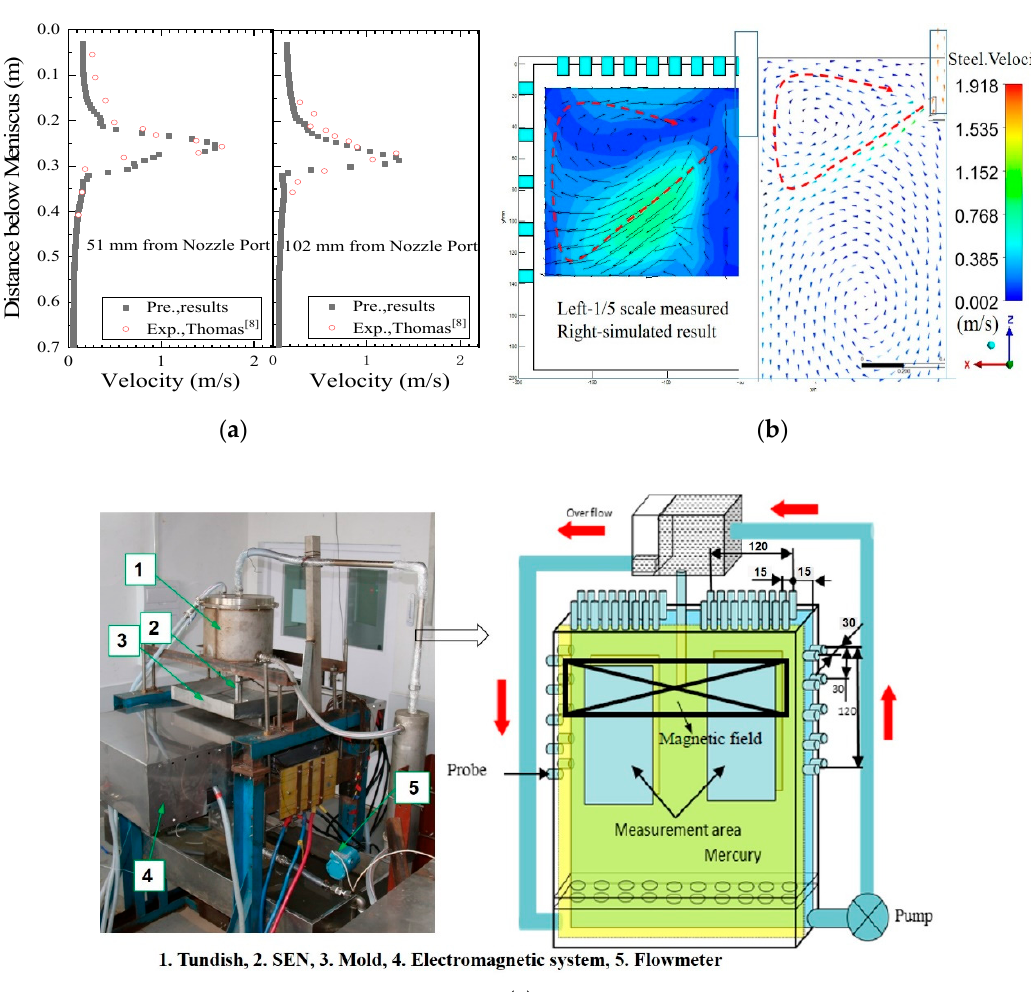
Figure 2. ( a ) Comparison of velocity profiles along two vertical lines at different distances from the submerged entry nozzle (SEN); ( b ) Comparison of molten steel velocity measured by physical experiment with that measured by simulation case 1; ( c ) Physical experiment system.